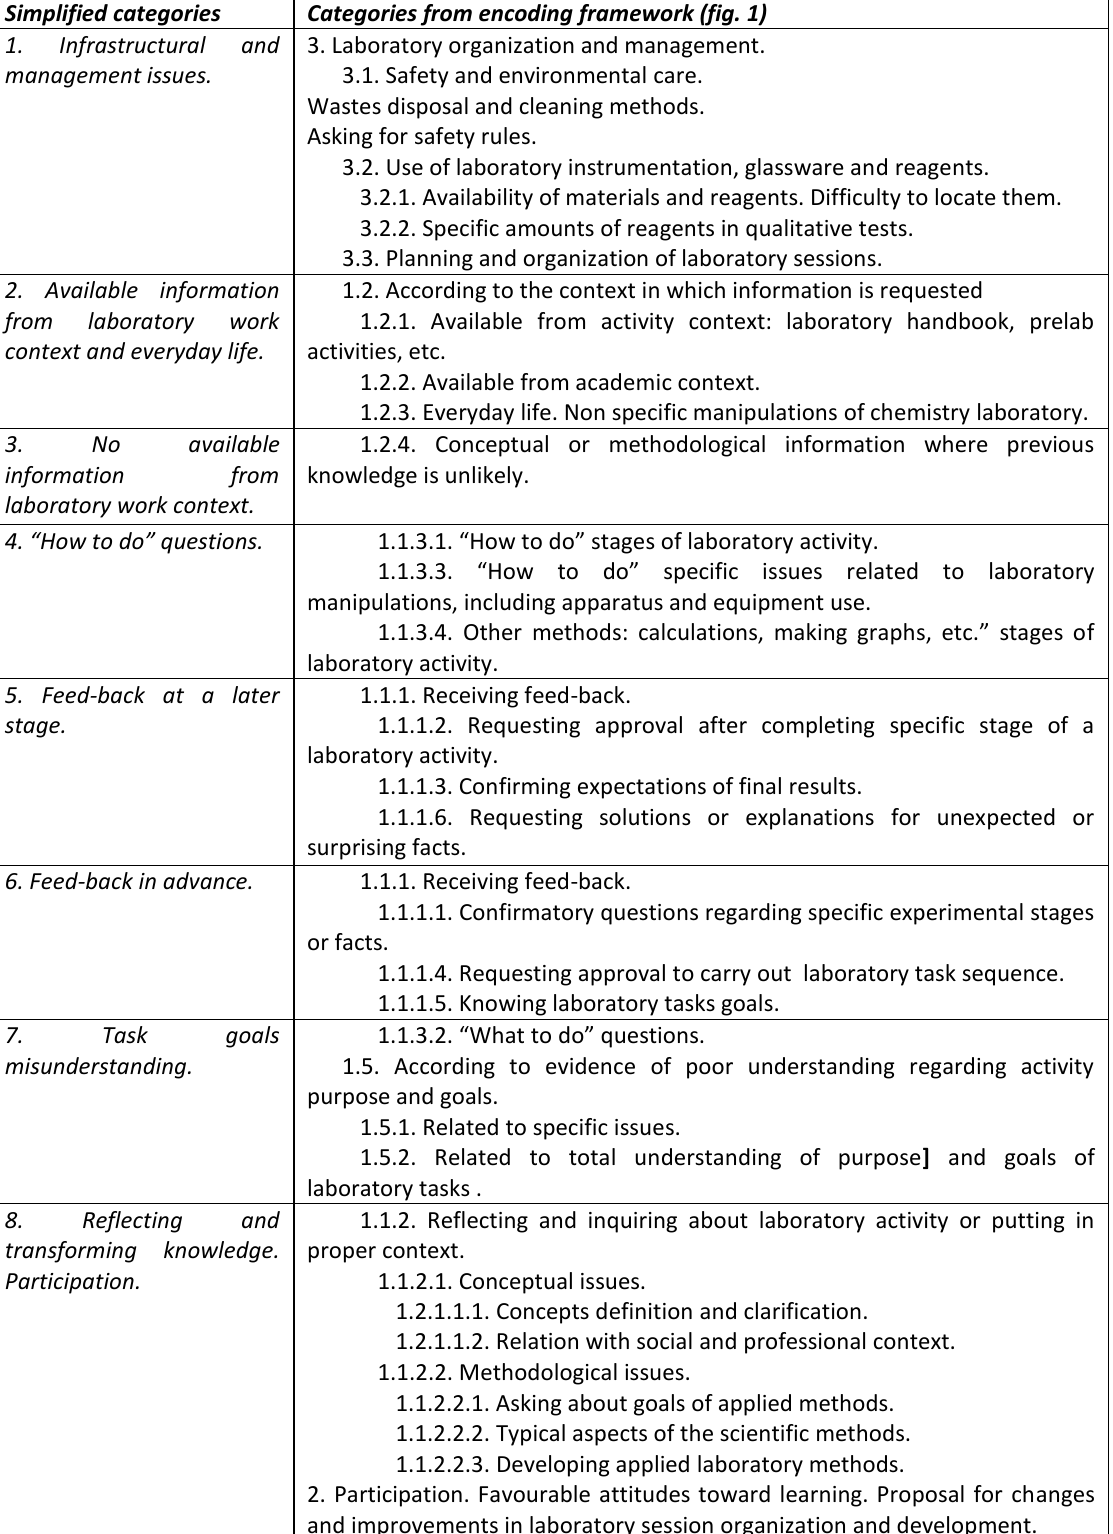
Table 1. Simplified categories and their correspondence with the ones from encoding